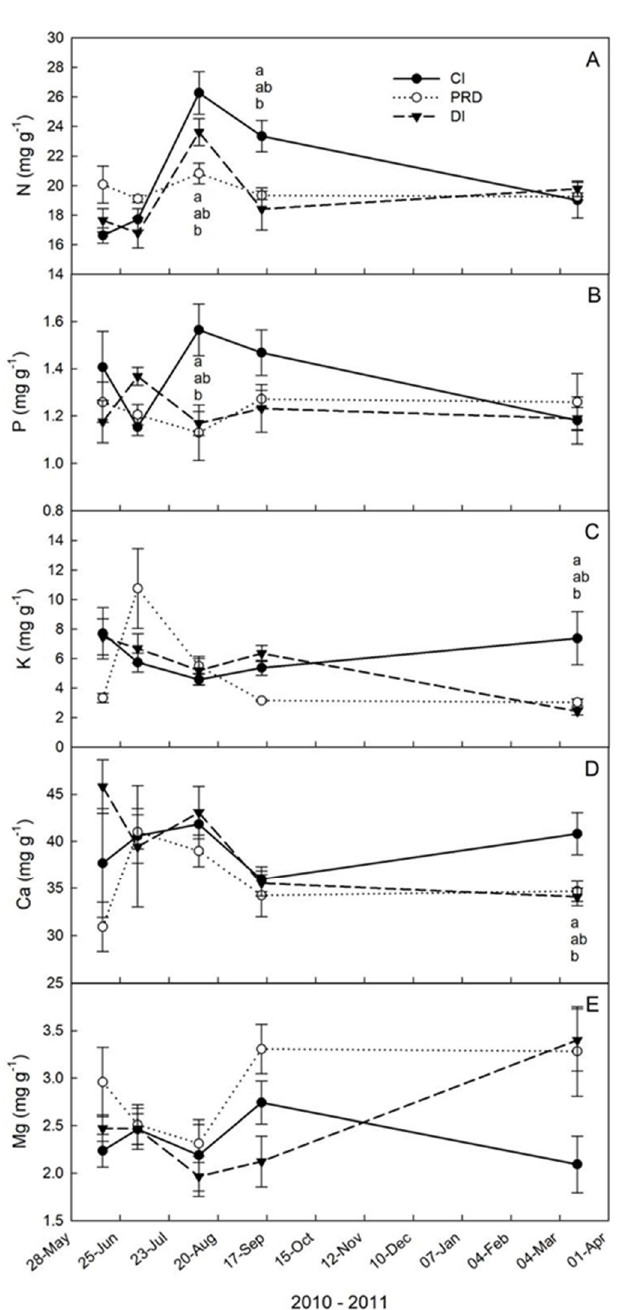
Figure 6. Nitrogen ( A ), phosphorus ( B ), potassium ( C ), calcium ( D ), and magnesium ( E ) content in leaves of adult ‘Valencia’ orange trees under conventional irrigation (CI), partial rootzone drying (PRD), and continuous deficit irrigation (DI) in the 2010–2011 cropping season. Error bars are standard errors of the means. Different letters indicate significant differences by Tukey’s multiple range test ( p < 0.05).